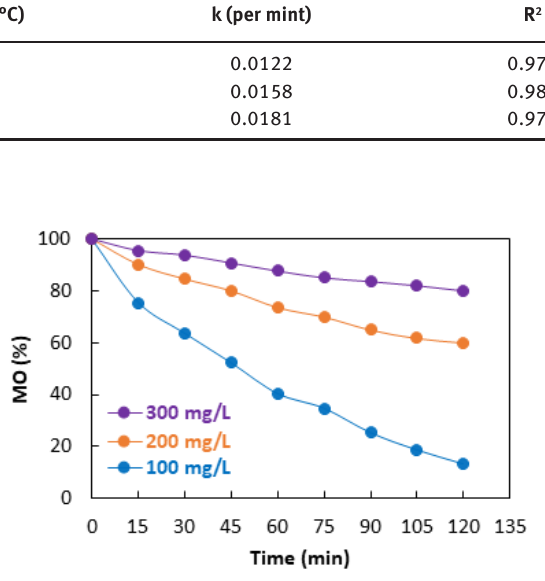
O catalyzed photo degradation 3 4